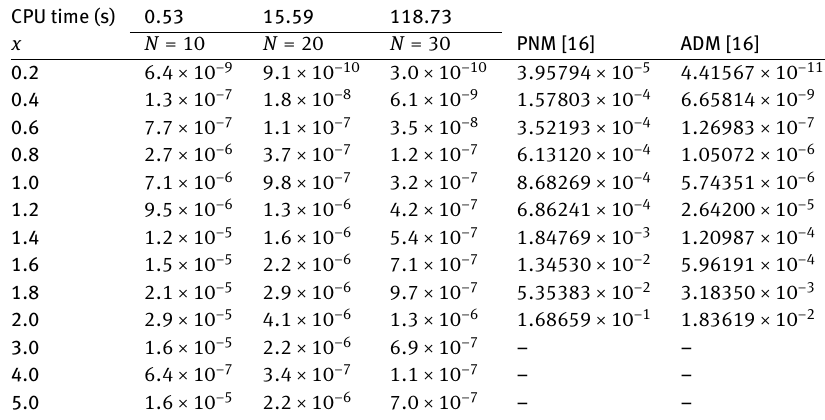
√ 2 √ 5 , α 2 = ) and h = 1 for Example 3. 5 2